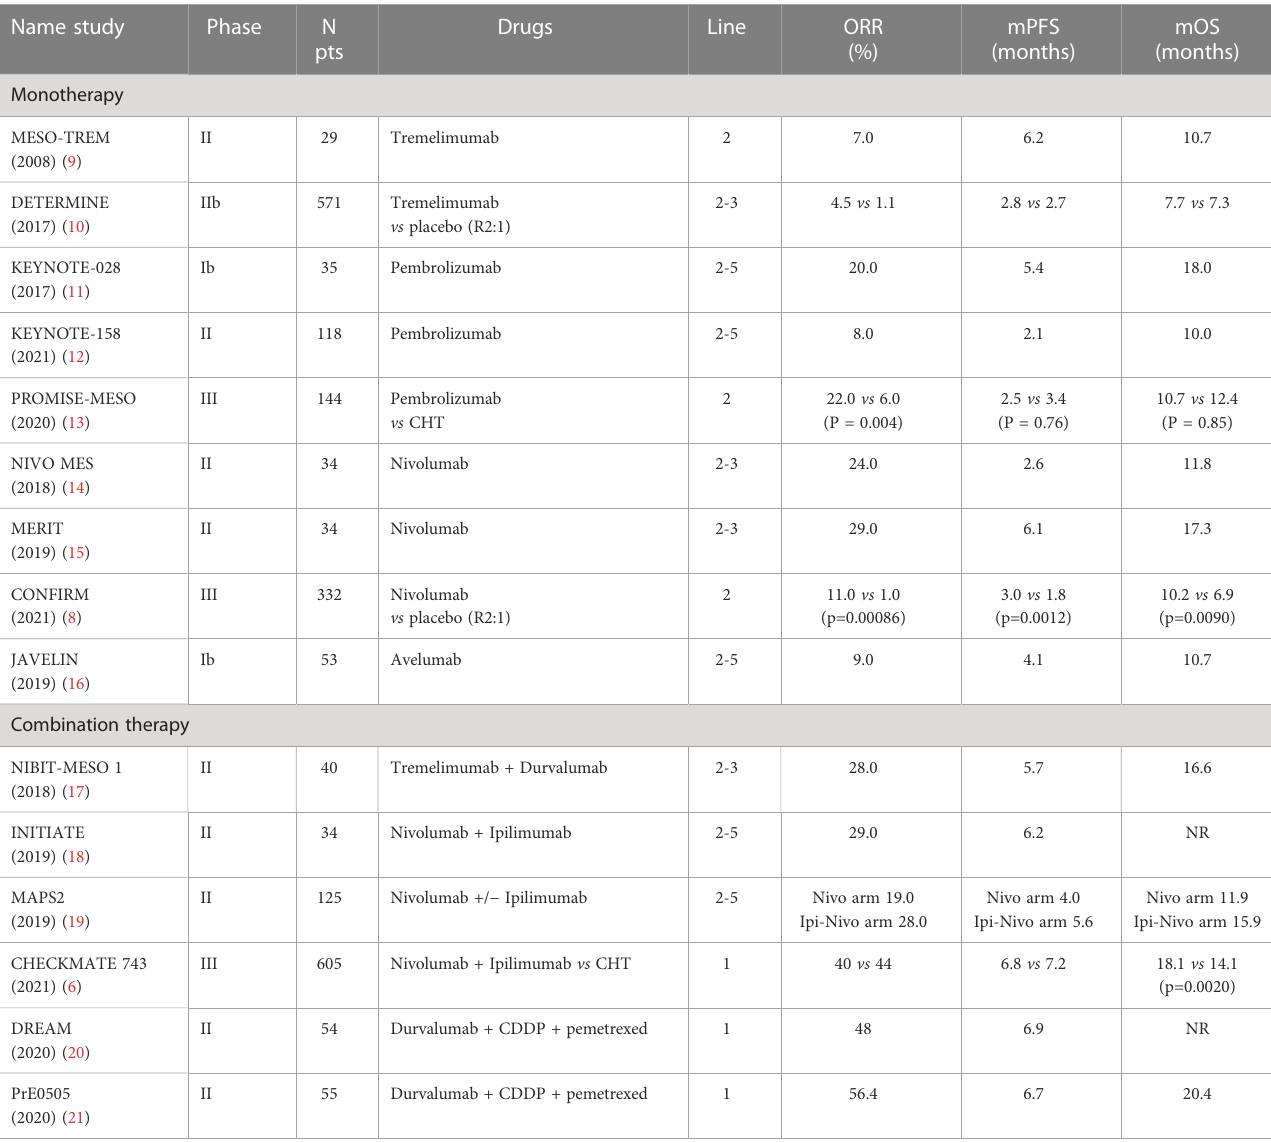
TABLE 1 Main trials of ICIs in malignant mesothelioma. Name